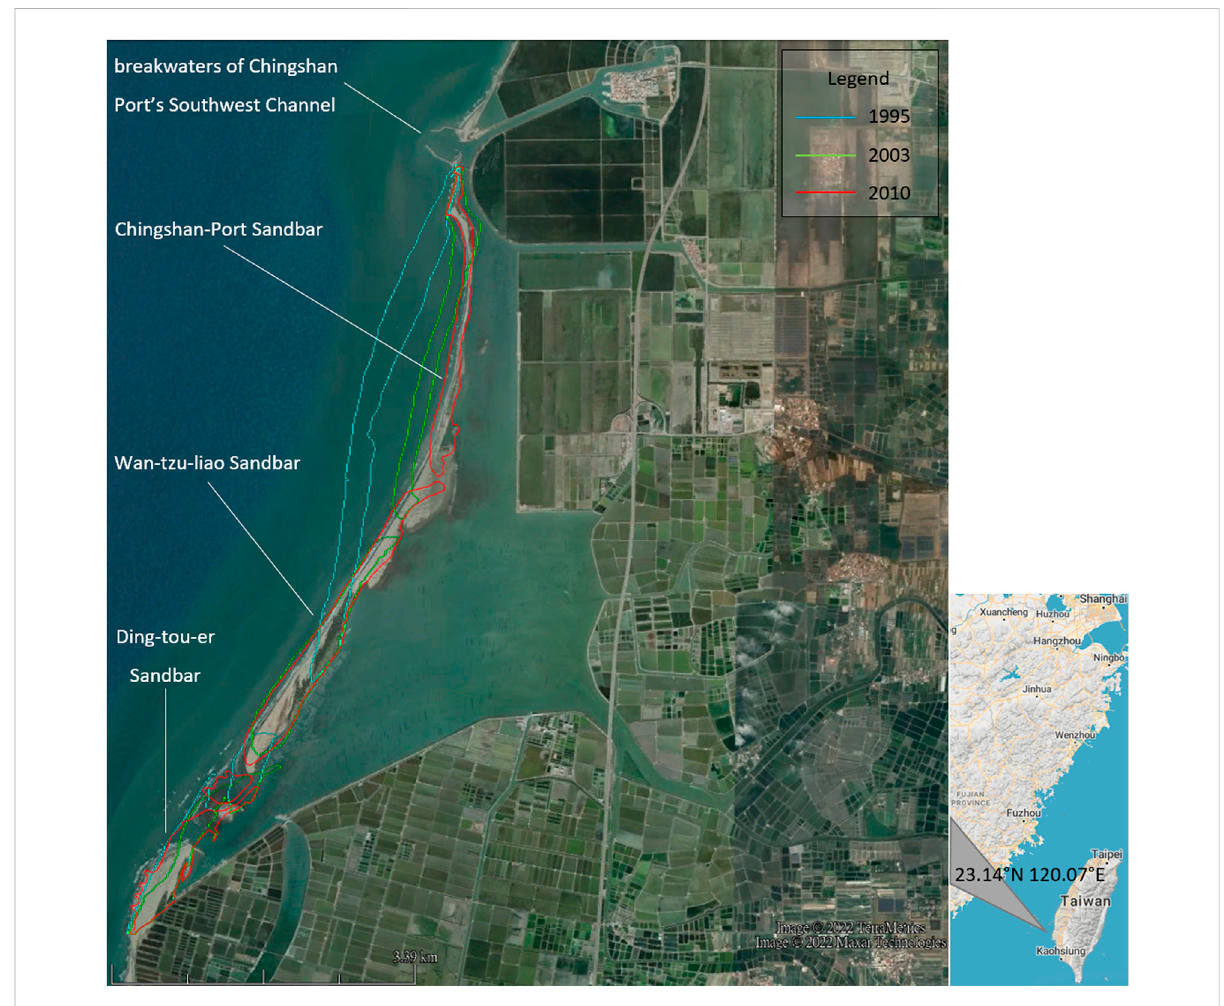
FIGURE 2 Map showing shoreline changes to Cigu Lagoon ’ s sand barrier islands over the years (underlying satellite image is from